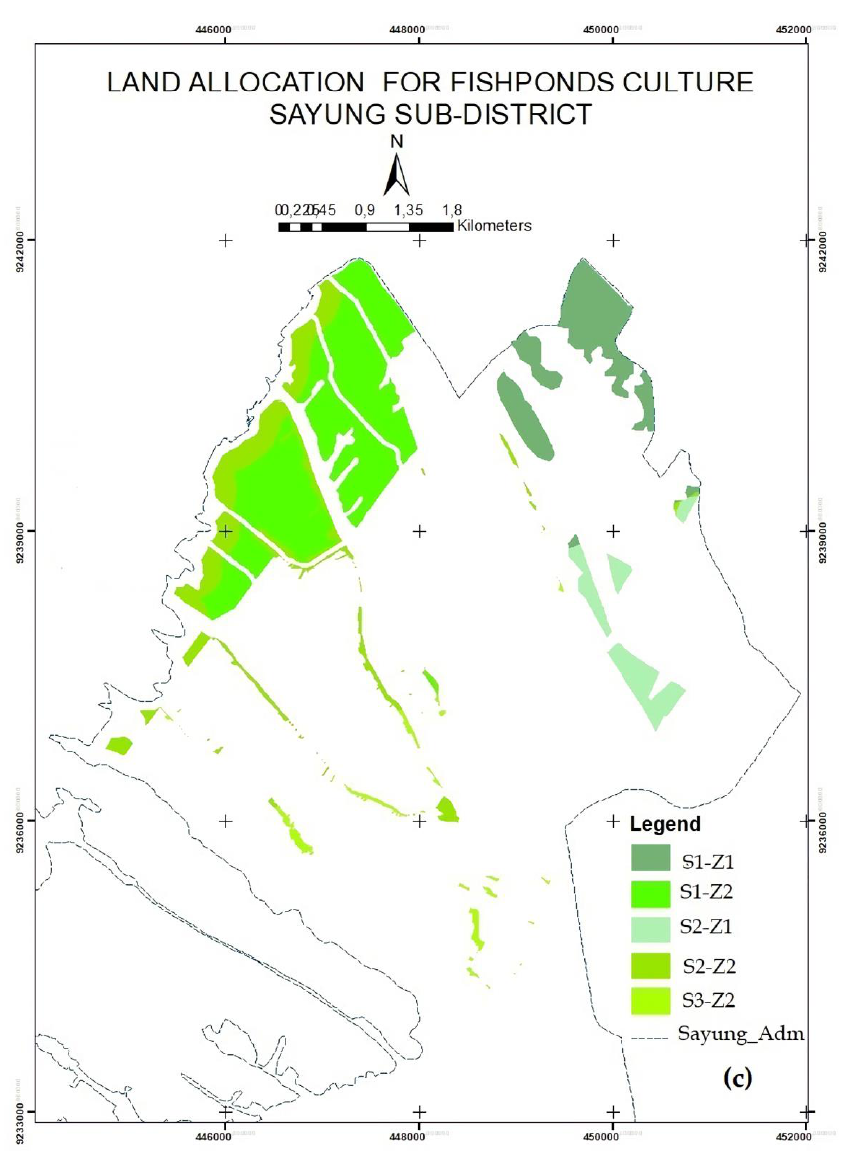
Figure 6. Fishpond spatial site allocation: ( a ) available land for fishponds; ( b ) regional spatial planning [52]; ( c ) land allocation for fishpond